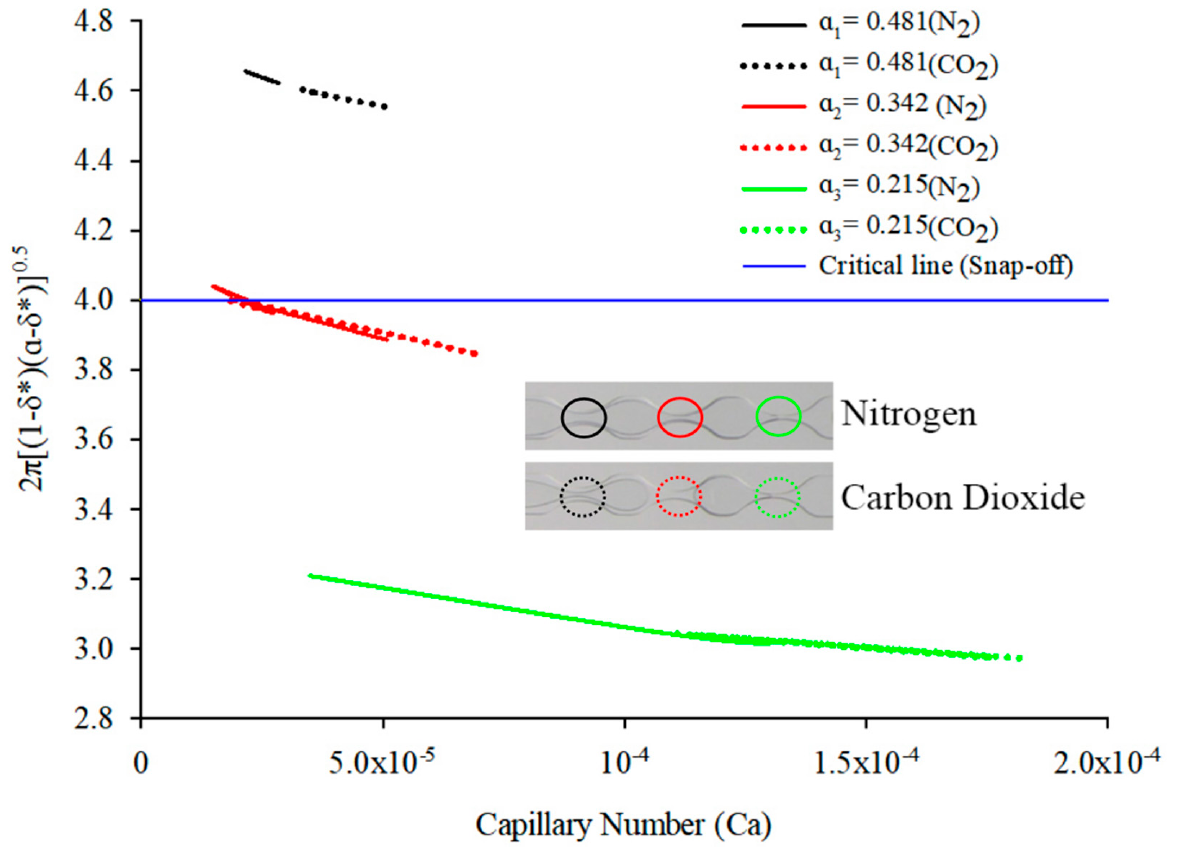
Figure 13. Snap-off